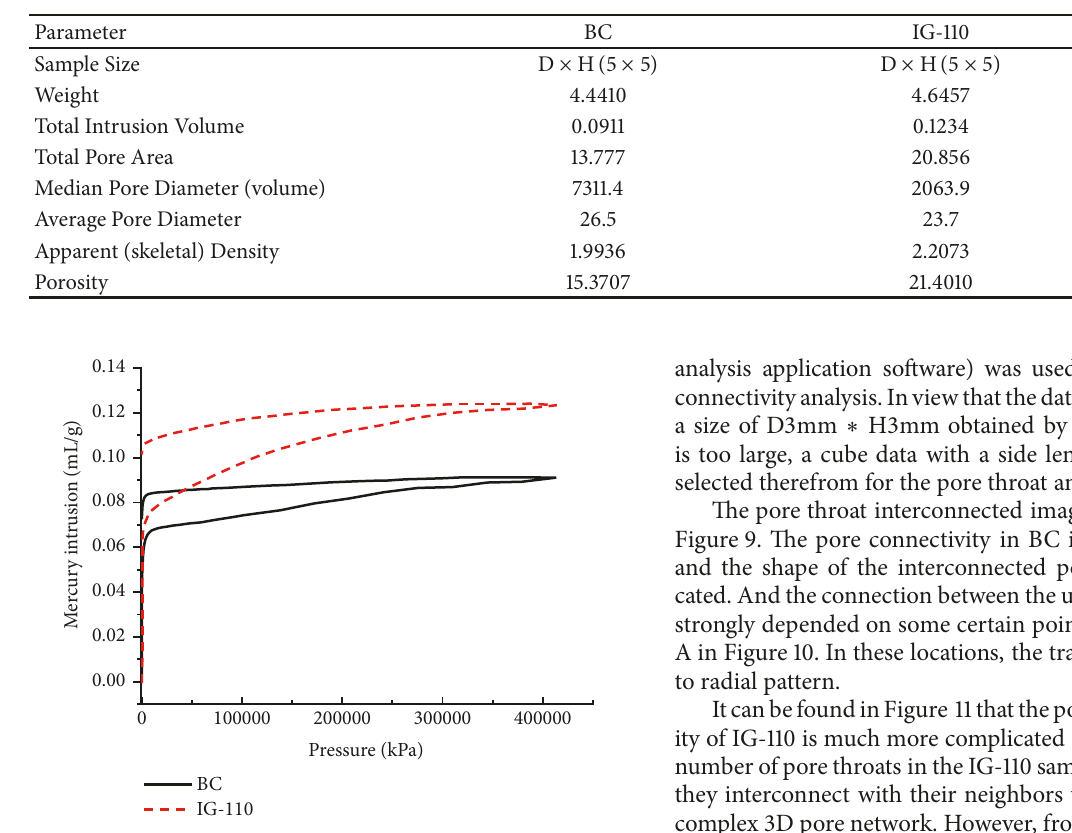
Table 2: The test results of BC and IG-110.